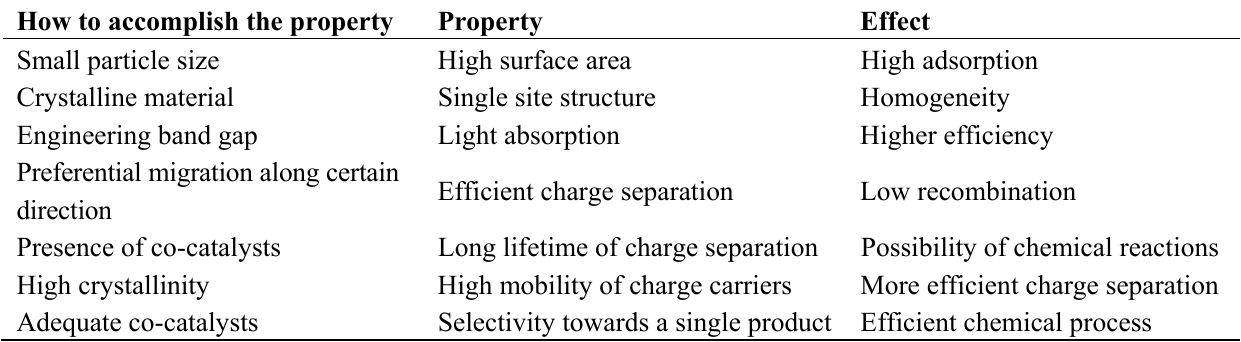
Table 2. Desirable properties of a